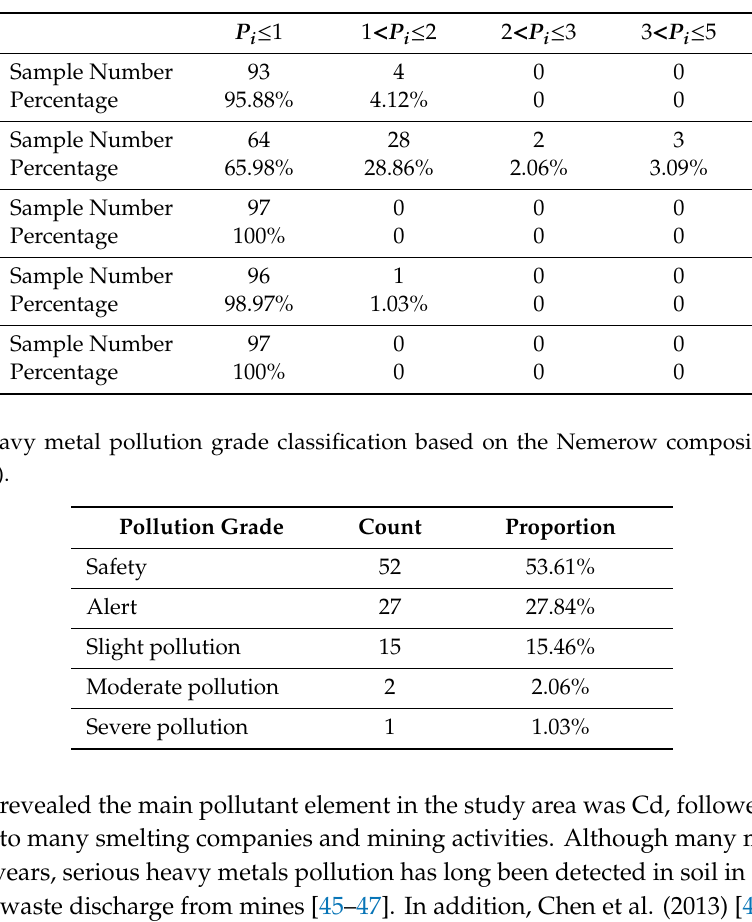
Table 2. Heavy metals pollution grade classification based on the single pollution index (SPI).